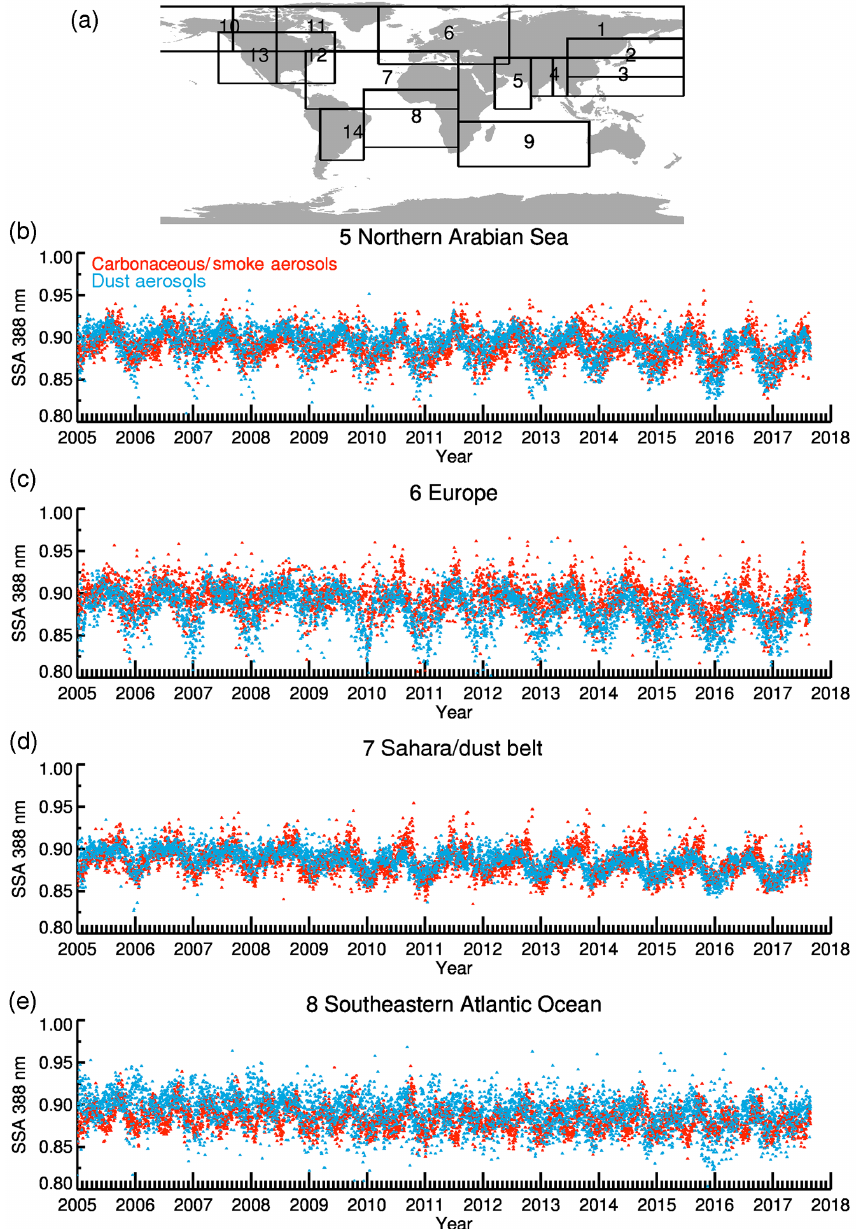
Figure 2. (a) Geographical boundaries of the 14 regions considered for calculating corresponding regional values of SSA (388nm). (b– e) Regional mean UVAI weighted cloud-free SSA (388nm) for carbonaceous and dust aerosols for the four selected regions (numbered 5, 6, 7, and 8 in a ) derived using OMI/OMAERUV operational (version 1.8.9.1) L2 cloud-free SSA